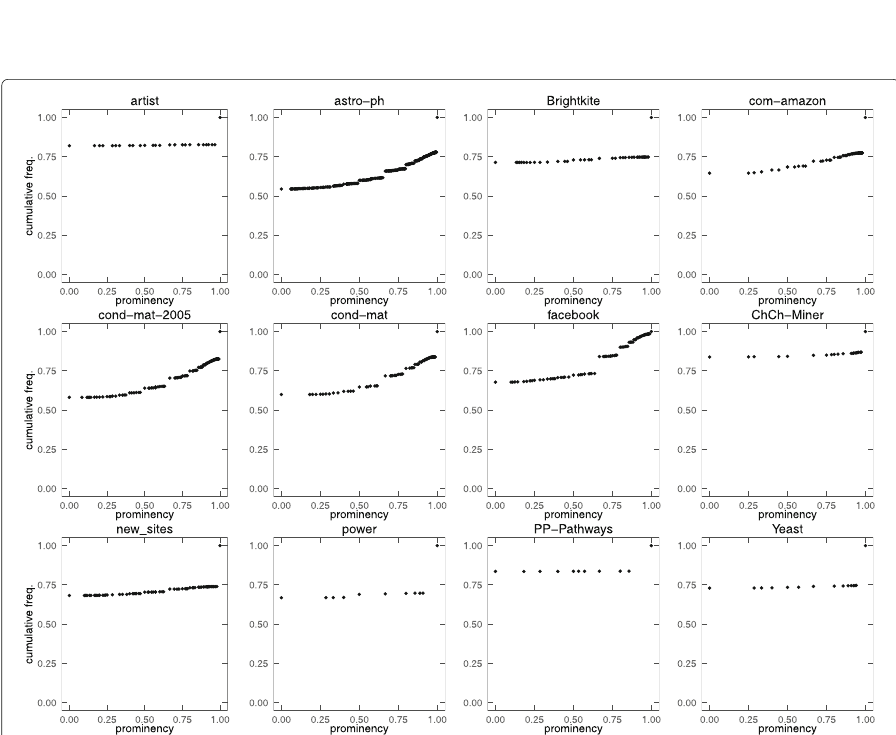
Fig. 24 Prominency in real-world